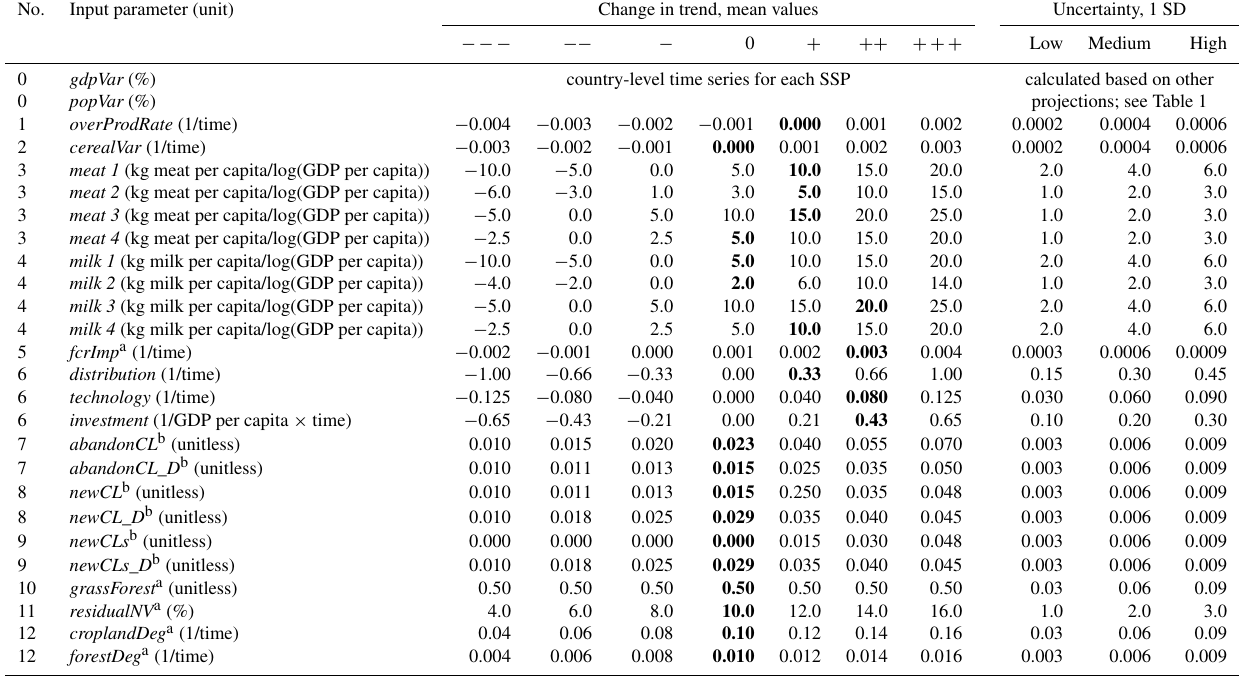
Table B1. Matrix with quantitative values for changes in trend from −−− to +++ (mean values) and the uncertainty levels low, medium and high (1 standard deviation, SD). Values are based on analysis of historical data, except that values with a were estimated by the author (see Engström et al., 2016). Superscript b indicates that values are maximum values rather than standard deviations. Values in bold are baseline values, corresponding to the baseline trend in Table